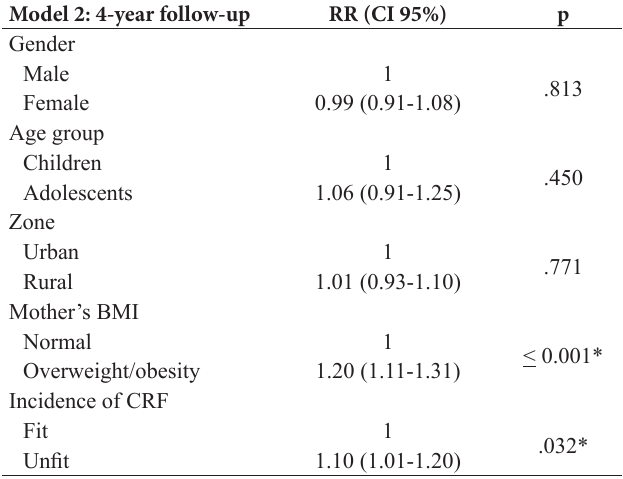
Table 4. Incidence of overweight/obesity and 4-year follow-up deter- minant variables.